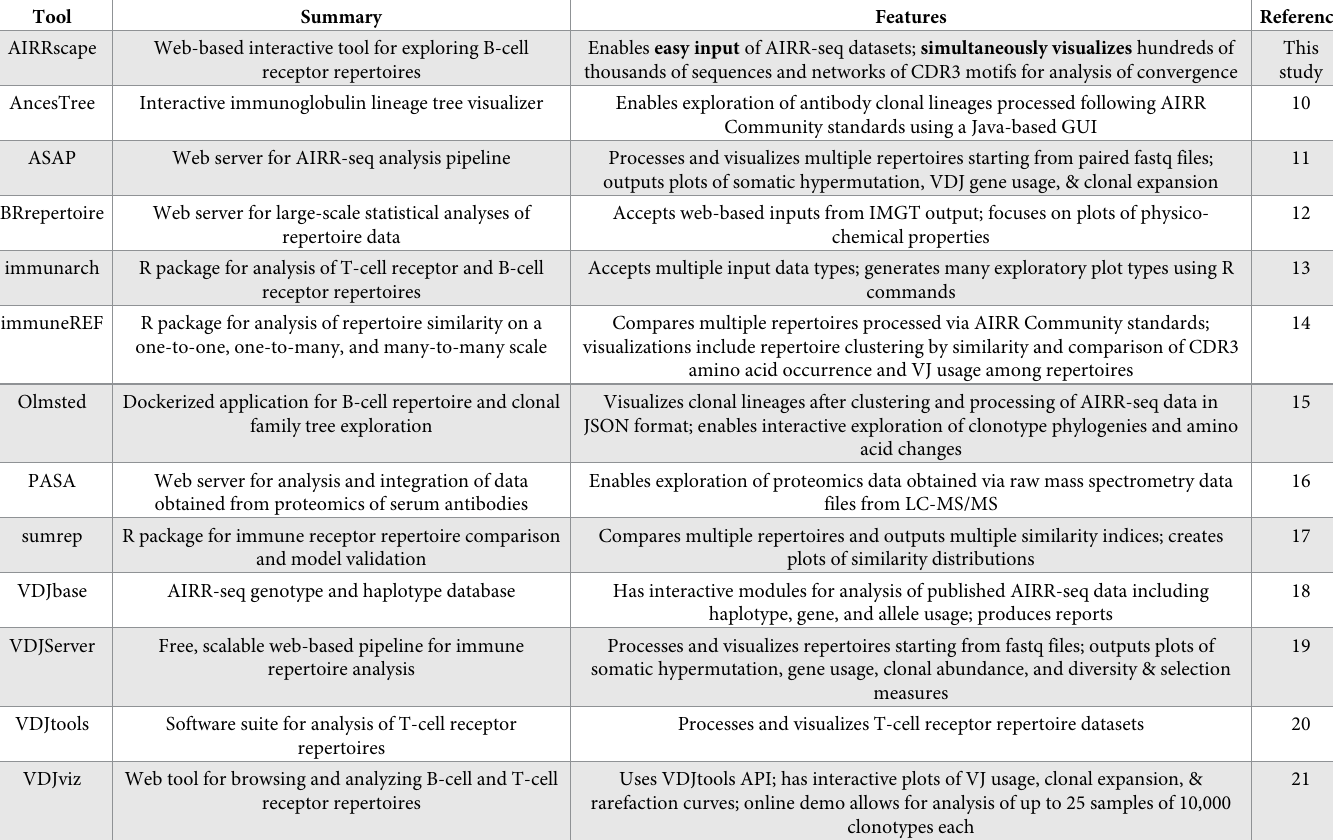
Table 1. Open-source tools for comparing and visualizing BCR